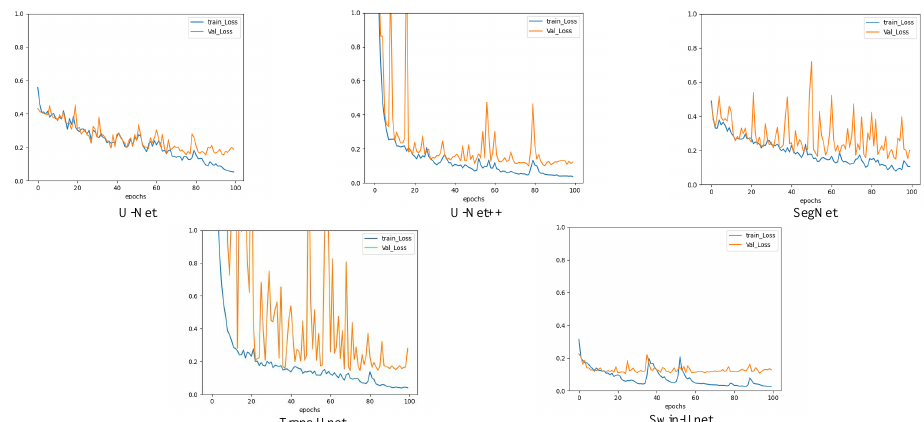
Figure 5. A comparison of the image segmentation results of the loss curves of deep learning on pixel-level training and validation sets.